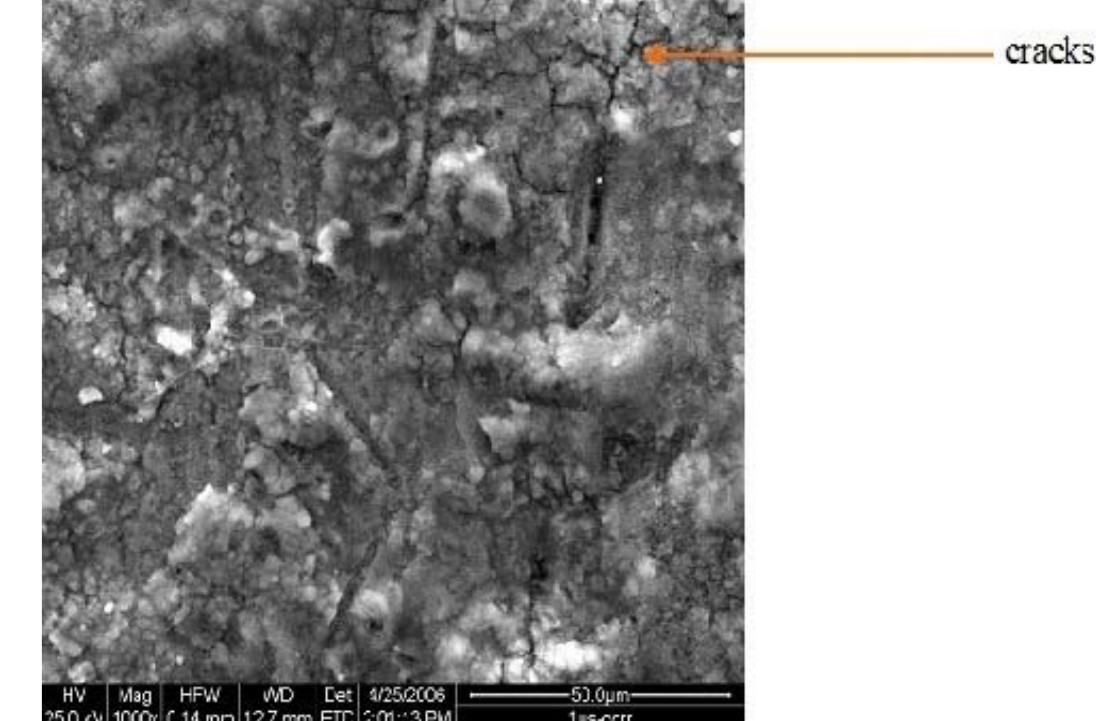
Figure 7. SEM of surface of 2hcd after polarization test in SBF.